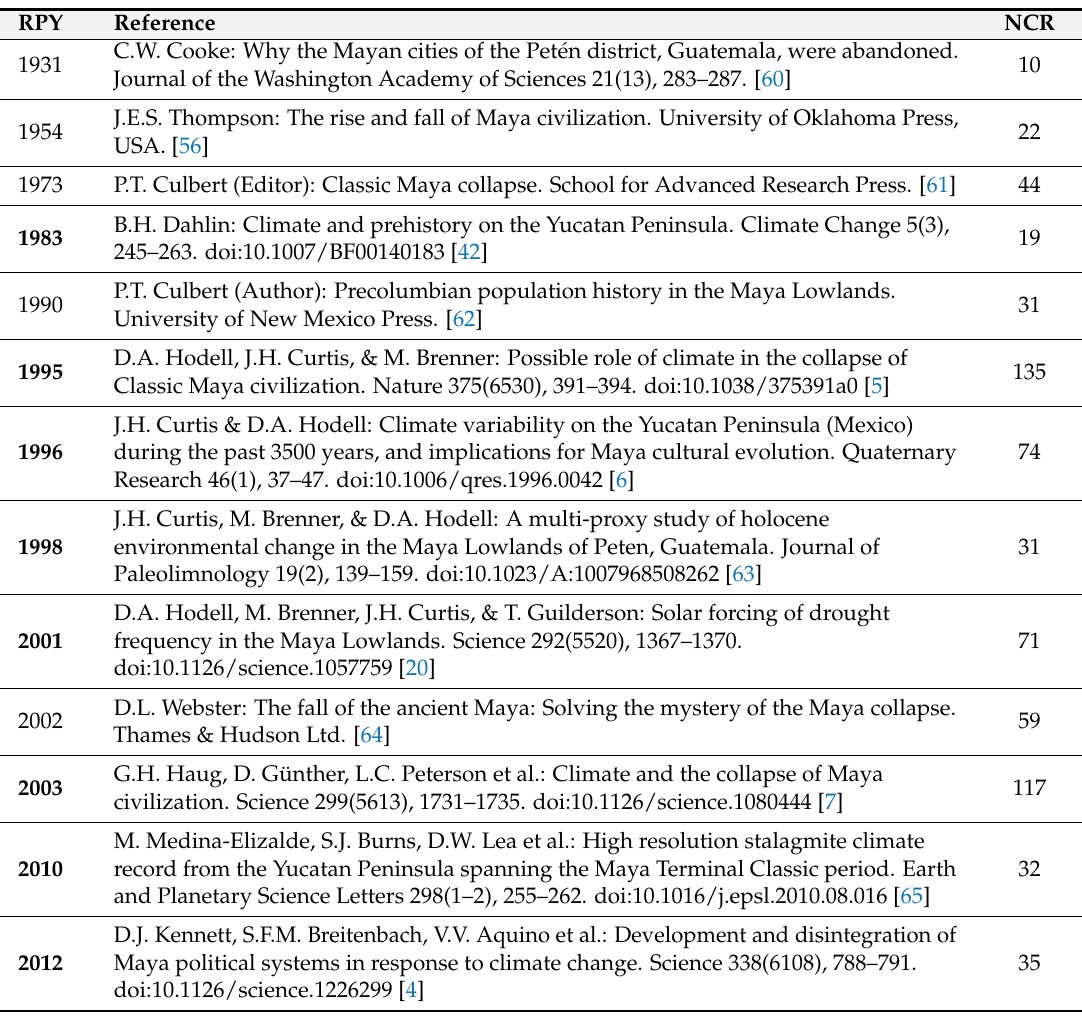
Table 1. The most frequently cited references from specific reference publication years cited by papers dealing with the collapse of the Maya civilization. For each reference, the corresponding reference publication year (RPY) and the number of cited references (NCR) within our publication set are listed (note that these are not the total citation counts according to the WoS times cited numbers). The publication years of the paleoclimatic papers are in bold. Source: